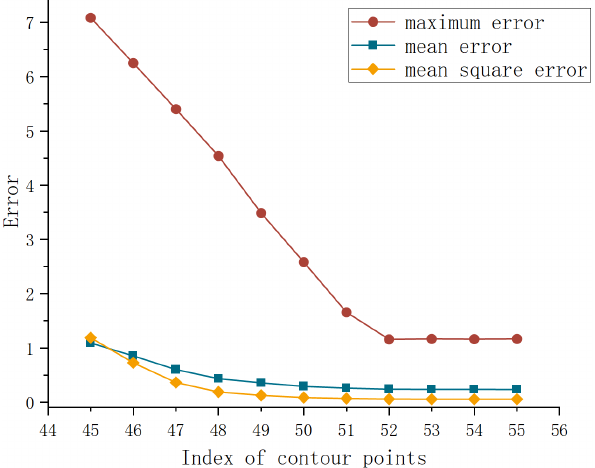
Figure 15. Fitting error of using 45–55 contour points as split points.